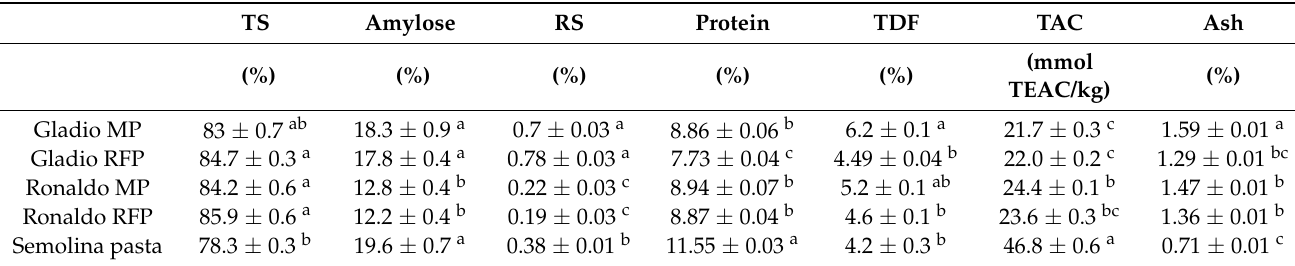
Table 1. Basic composition and total antioxidant capacity of pasta.